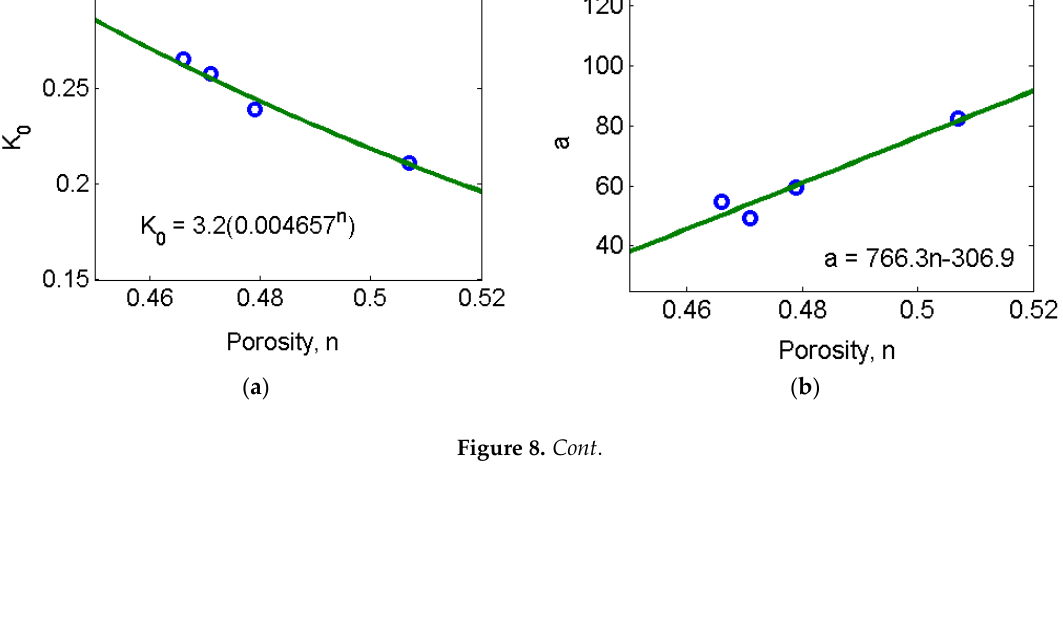
Figure 7. The Modelling Results using Equations (4a) and (7a), ( a ) porosity n = 0.507; ( b ) porosity n = 0.479; ( c ) porosity n = 0.471; ( d ) porosity n = 0.466.